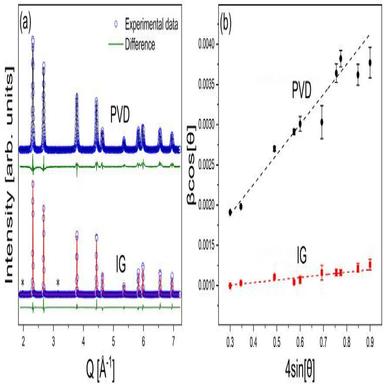
(a) XRD data (blue) and structural refinements for ZrC synthesized via IG (red) and PVD (black) with respective difference curves (green). (b) Williamson-Hall analysis based on XRD patterns of both ZrC samples. Dashed lines are linear fits to the data points that yield grain size and microstrain. Error bars were propagated using propagation of standard error applied to Eq. ∗ denotes carbon peaks.